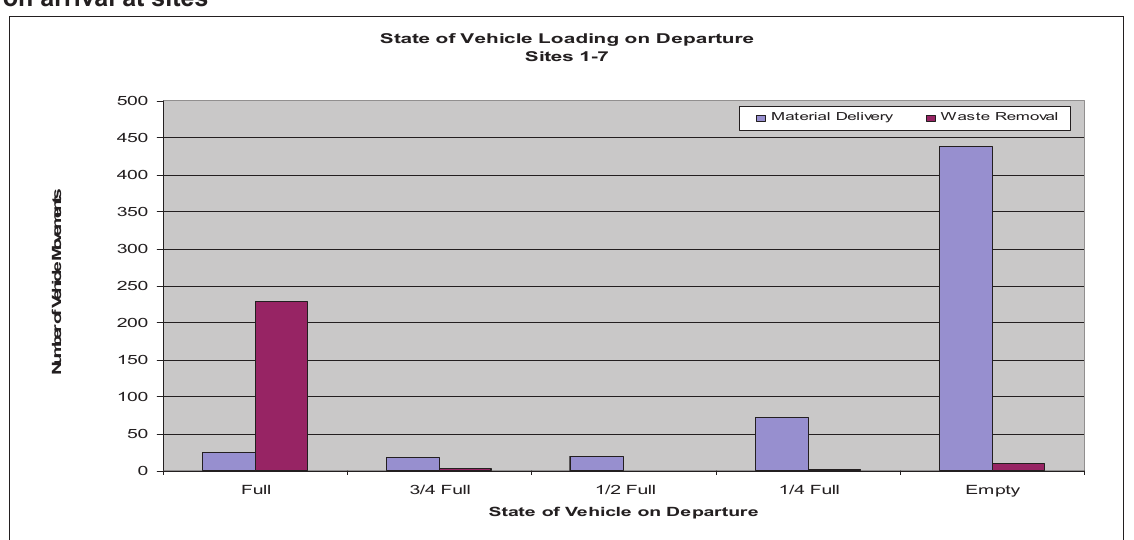
Figure 4 Loading levels of materials delivery and C&D waste removal vehicles on departure from